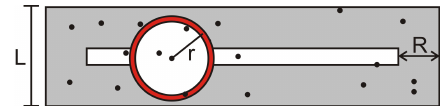
Figure 2. Another cartoon of the guard area technique used to es- timate the radial distribution function. Note that the fraction of the particles contributing to the sum in Eq. (3) decreases as the aspect ratio increases, and no estimate of the radial distribution function can be made for any distance larger than half the shortest dimension of the sample volume (when r ≥ L/ 2, no “inner” region